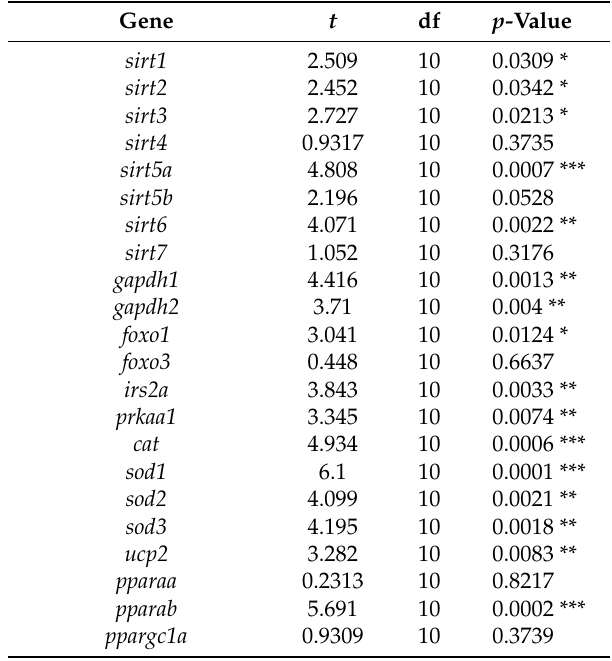
Table 1. Statistical comparisons (Student’s t -test) of target gene expression in livers of tilapia fed with Ctrl and